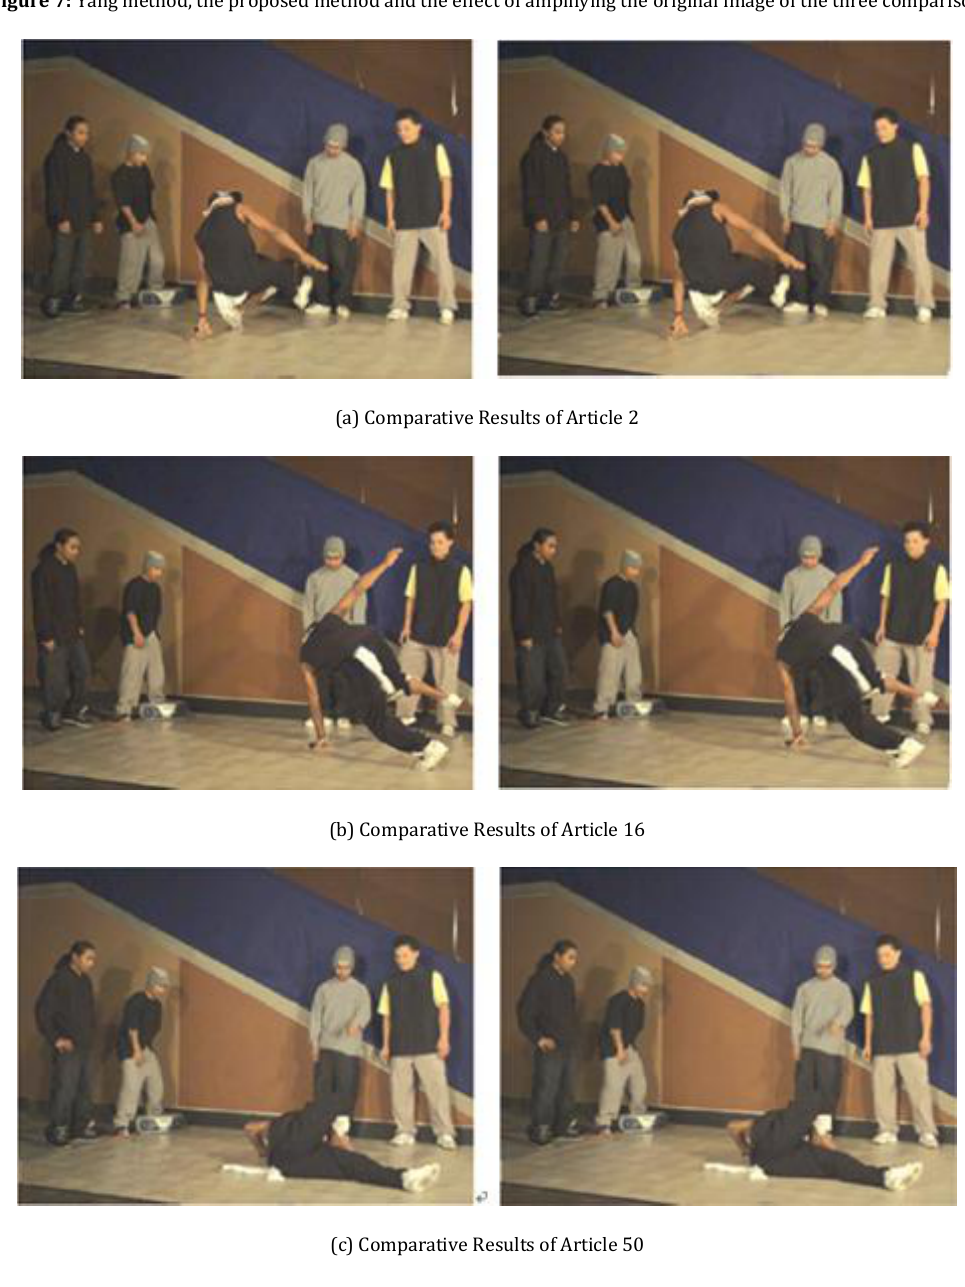
Figure 8: Contrast effect of using of Yang method and the method of paper to synthesis other image